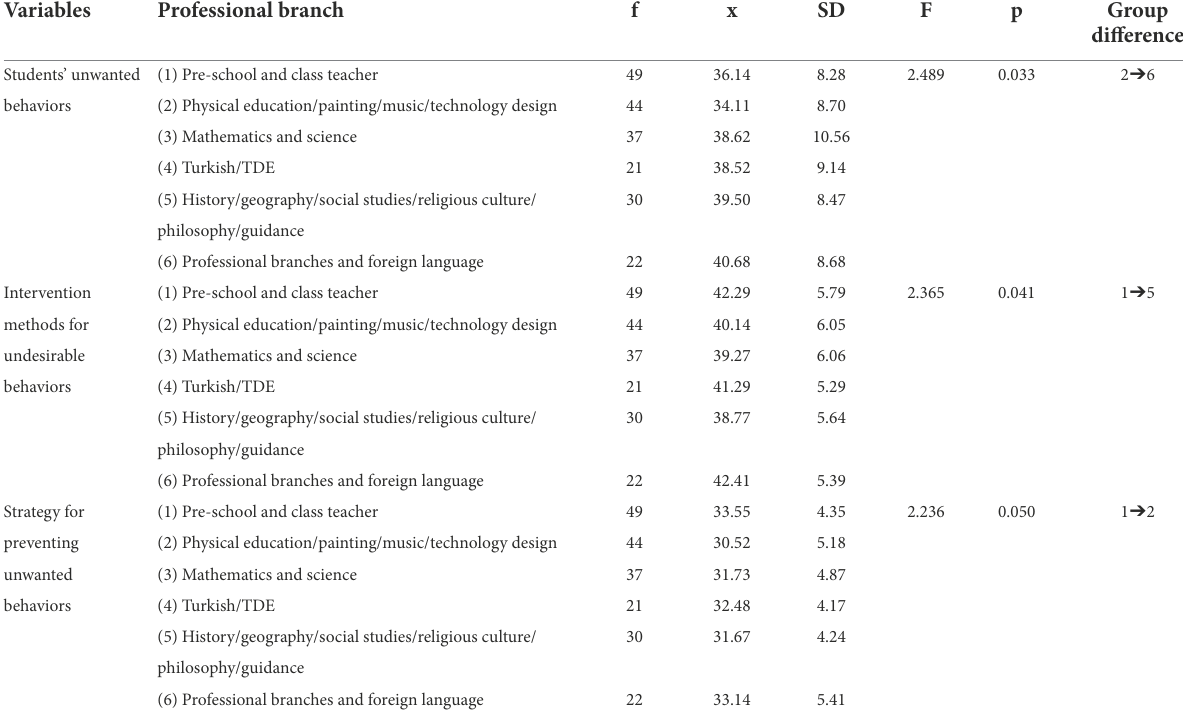
TABLE 4 Differentiation status of total scores obtained from variables by occupational branch.